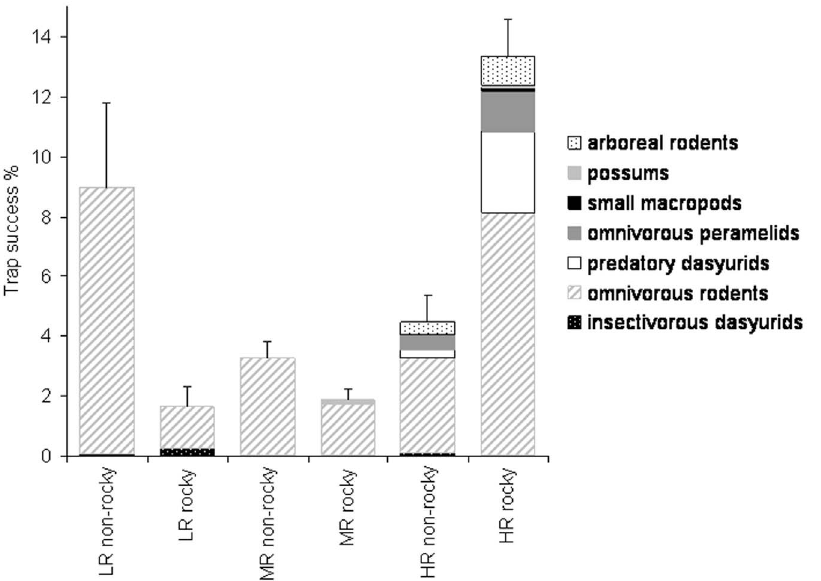
Figure 2. Trap success (mean + SE) of the major mammal functional groups (see key) recorded in different habitats in surveys across the Kimberley, northern Australia. Habitat types are defined by rainfall zone (H = High ( . 800 mm), M = Medium (600–800 mm) and L = Low ( , 600 mm)) and savanna habitat structure (rocky or non-rocky).